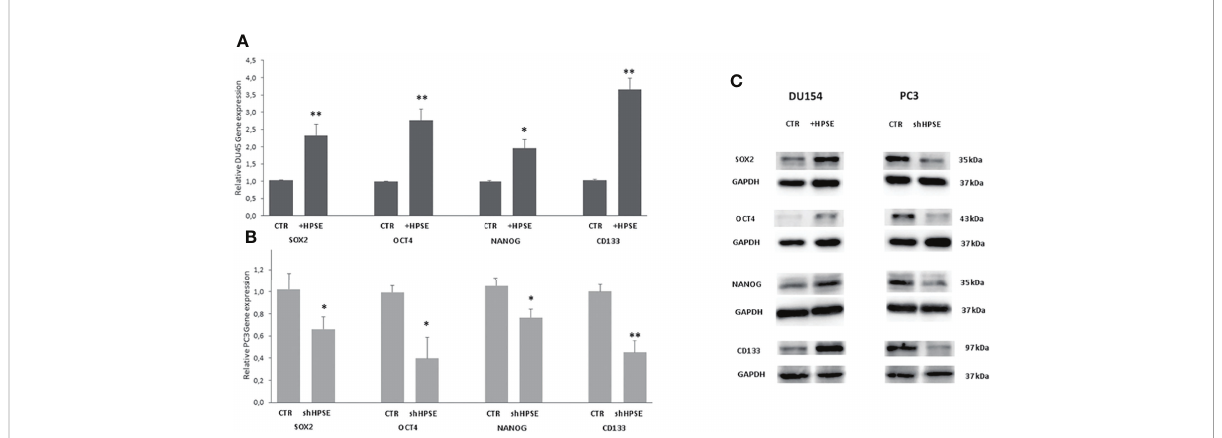
FIGURE 3 Stemness markers expression in prostate cancer cells. SOX2, OCT4, NANOG, and CD133 gene expression were evaluated by real-time PCR in DU145 (A) and PC3 (B) cells. Data were normalized to GAPDH expression. Means ± SD (error bars), n=6. **p < 0.001, *p<0.05 vs. (C) SOX2, OCT4, and NANOG protein level were quanti fi ed by WB in DU145 and PC3 cells. GAPDH was included as loading control.